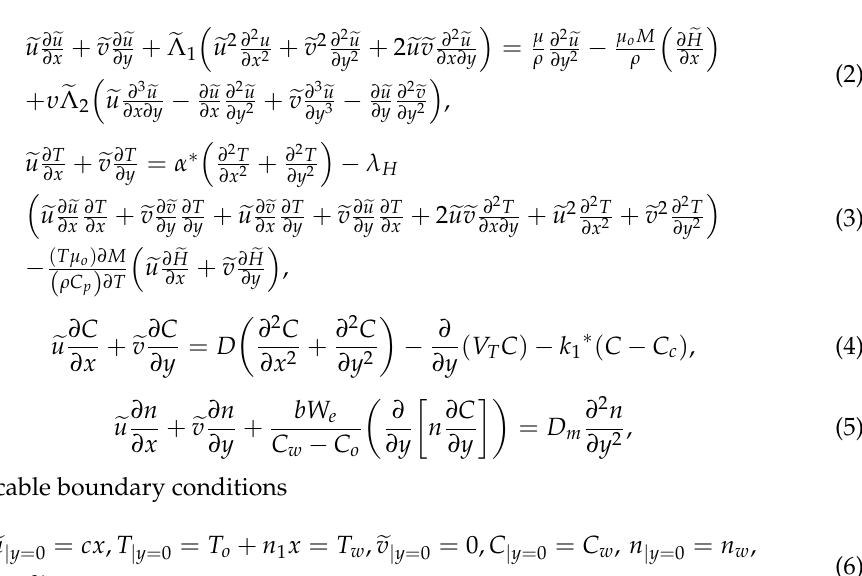
Figure 1. The geometry of the flow ( a ) boundary layers configuration ( b ) magnetic dipole placement.